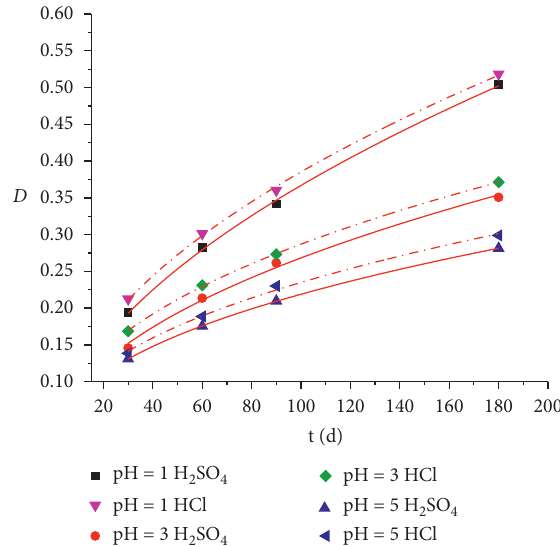
Figure 11: Relationship between the damage variables of the sandstone samples and soaking time.